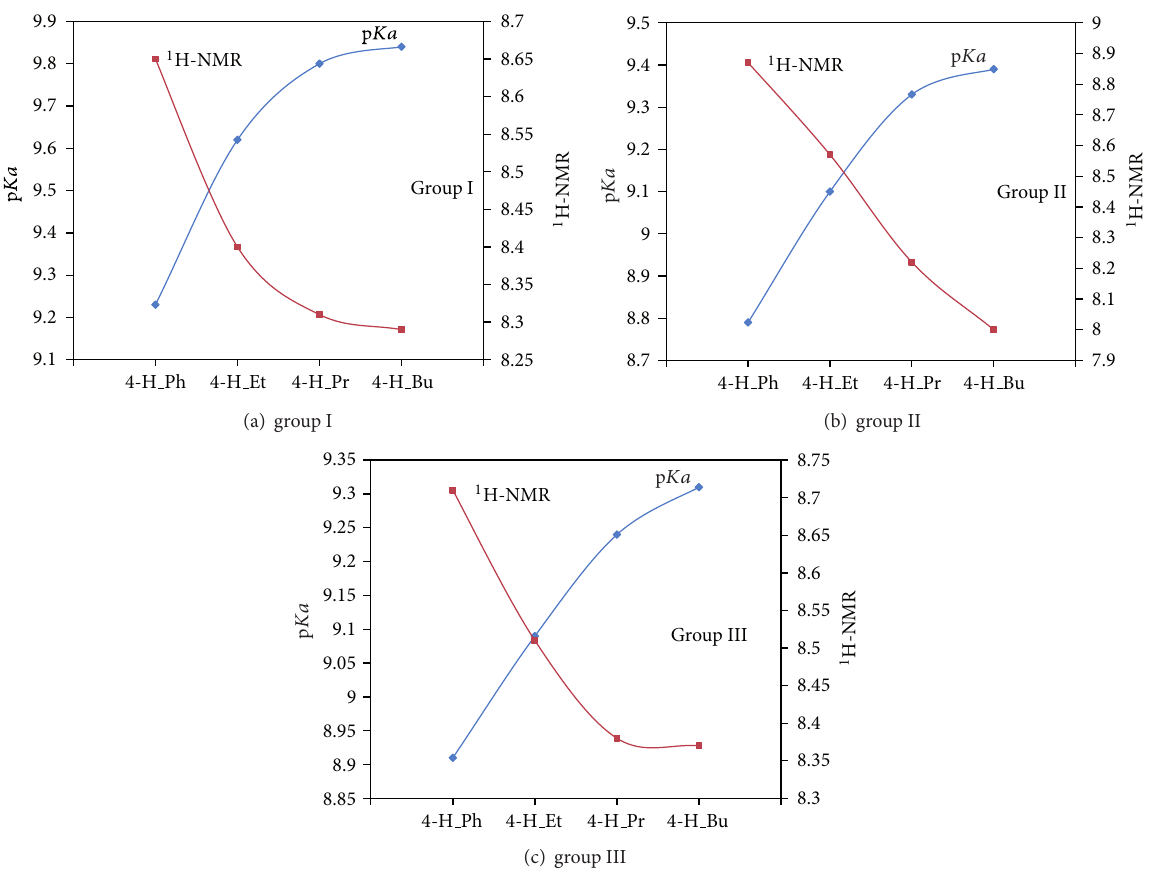
F 2: e relationship between the mean p